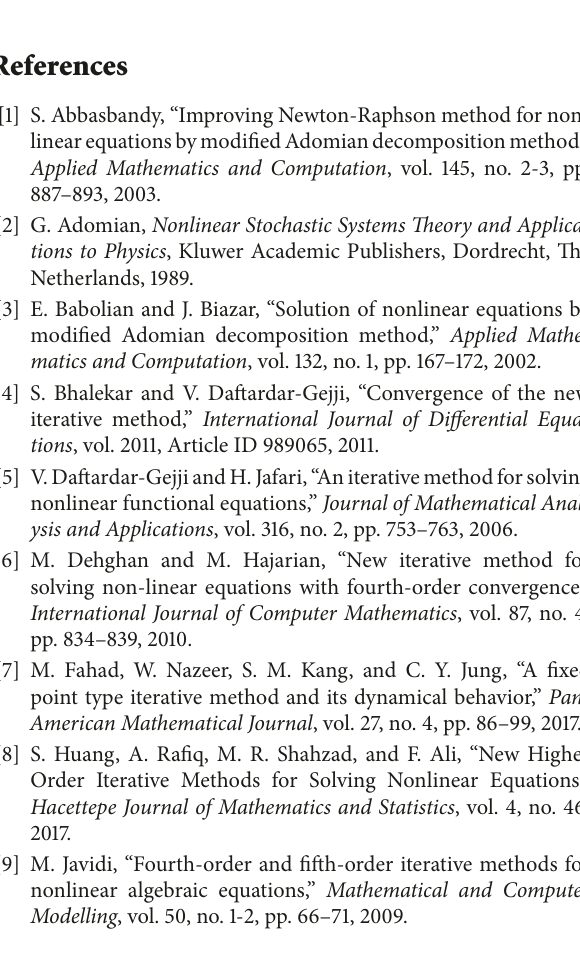
Figure 2: Log of residuals for equation